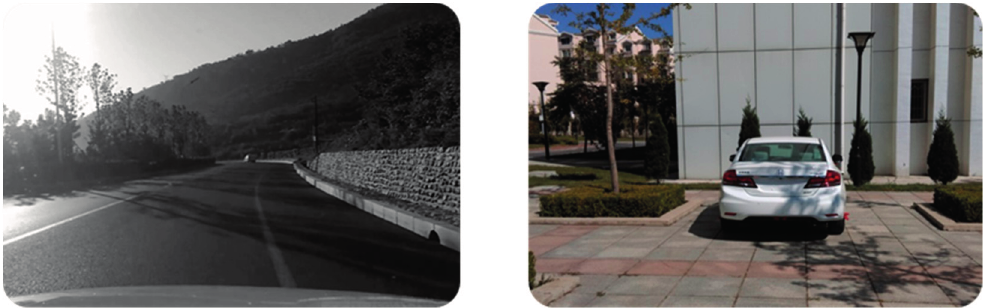
Figure 10. Statistics of the moment with different